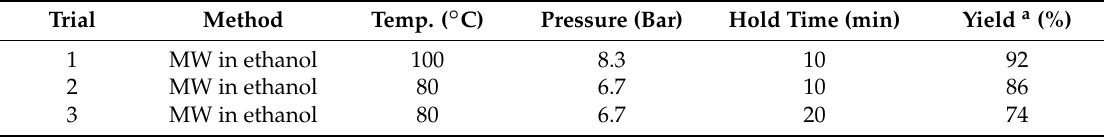
Table 1. Step 2: experiments to prepare the title compound ( L ) using different heating methods. Trial Method Temp. ( ◦ C) Pressure (Bar) Hold Time (min) Yield a (%) 1 MW in ethanol 100